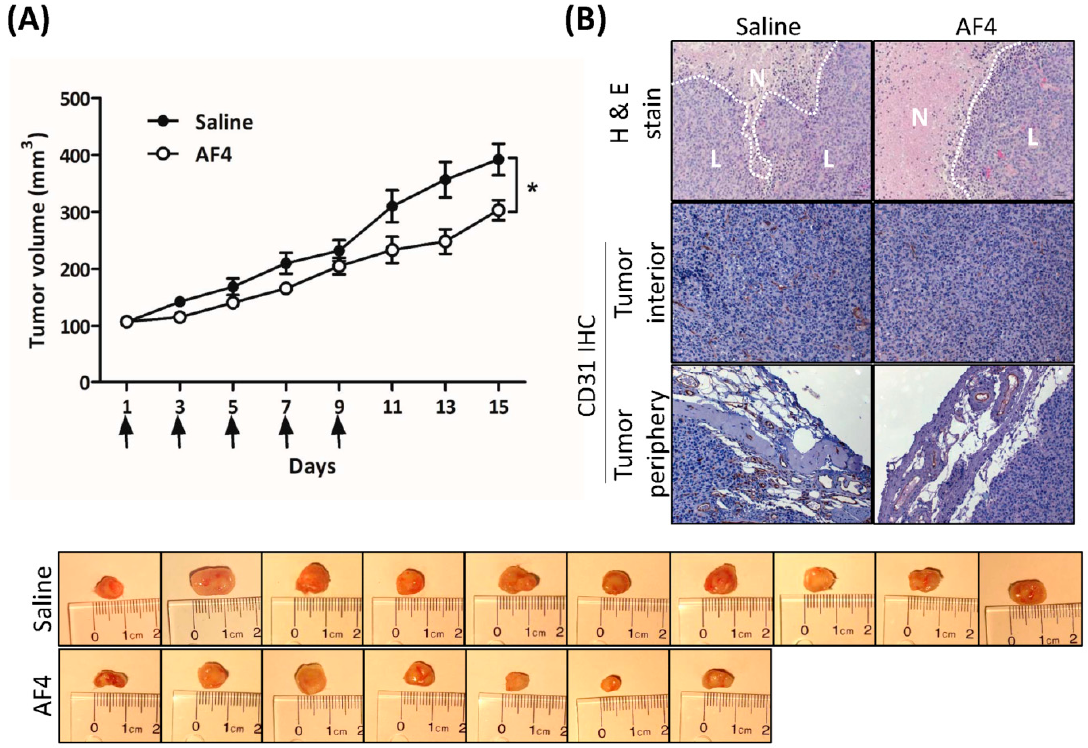
Figure 6. AF4 suppresses MDA-MB-231 xenograft growth. MDA-MB-231 cells were xenografted into the left flank of non-obese diabetic severe combined immunodeficient (NOD-SCID) female mice and